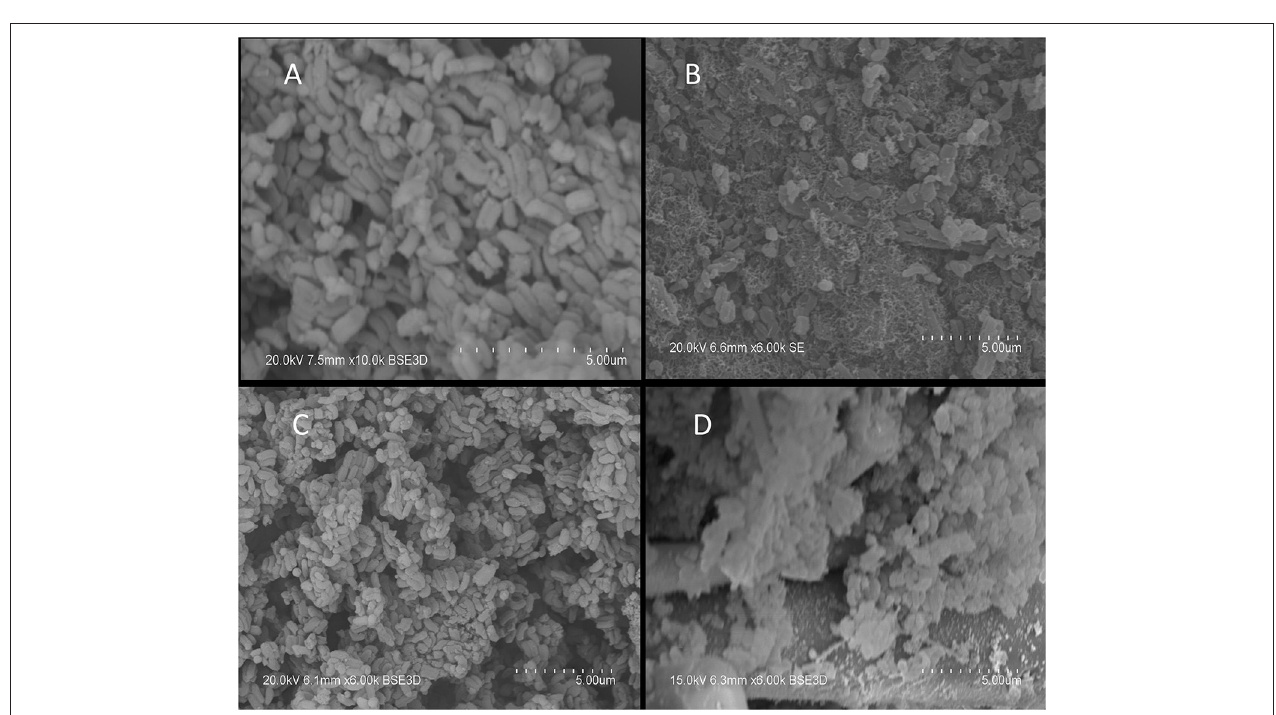
FIGURE 3 | SEM images of 6IMPNiN-A [ (A) fresh and (B) spent, 550 ◦ C] and 29IMPNiN-C [ (C) fresh and (D) spent, 550 ◦ C] catalysts.